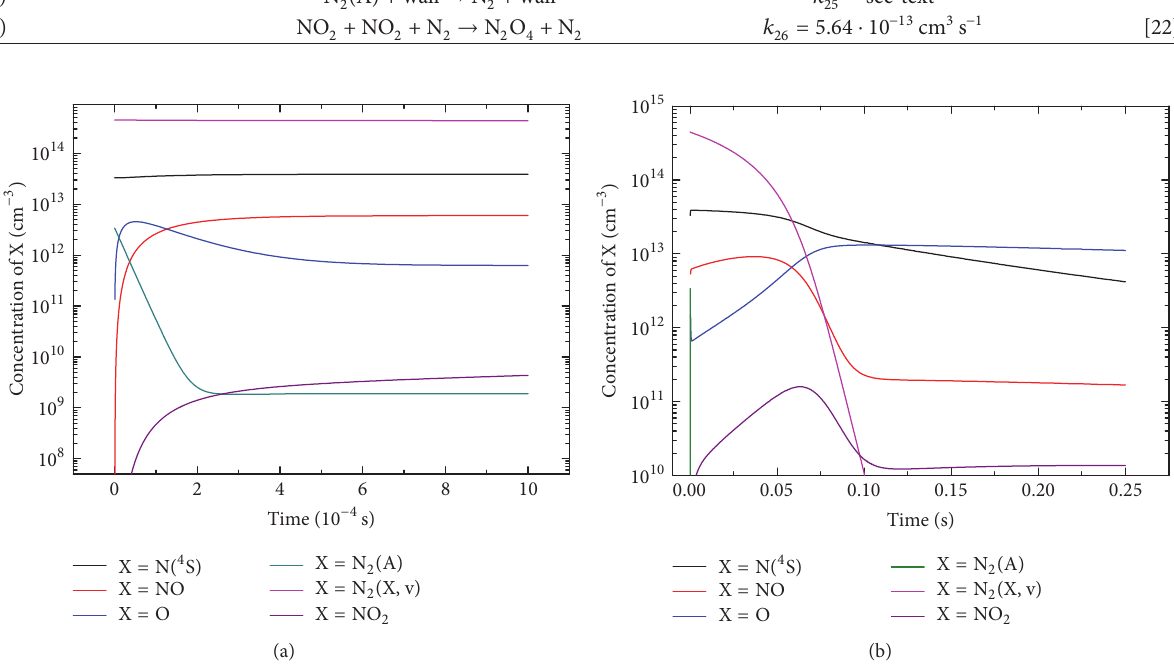
Figure 8: The temporal evolution of main species considered in the reduced kinetic model of N 2 -O 2 afterglow. For clarity, the data are shown in two time